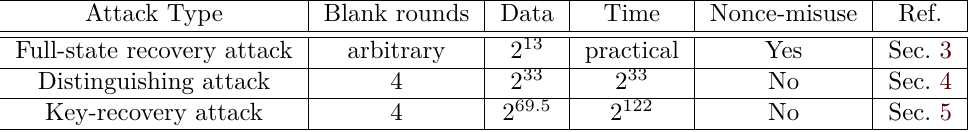
Table 1: The analytical results of Subterranean-SAE. The time complexity represents the required number of calls to the internal permutation of Subterranean-SAE. The data complexity represents the required number of 32-bit blocks. The associated data are all set to empty in the three